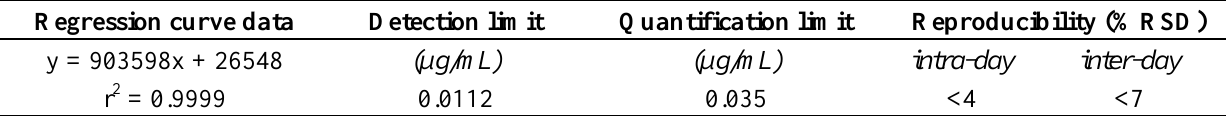
Table 1. Regression curve data, detection limit, quantification limit and